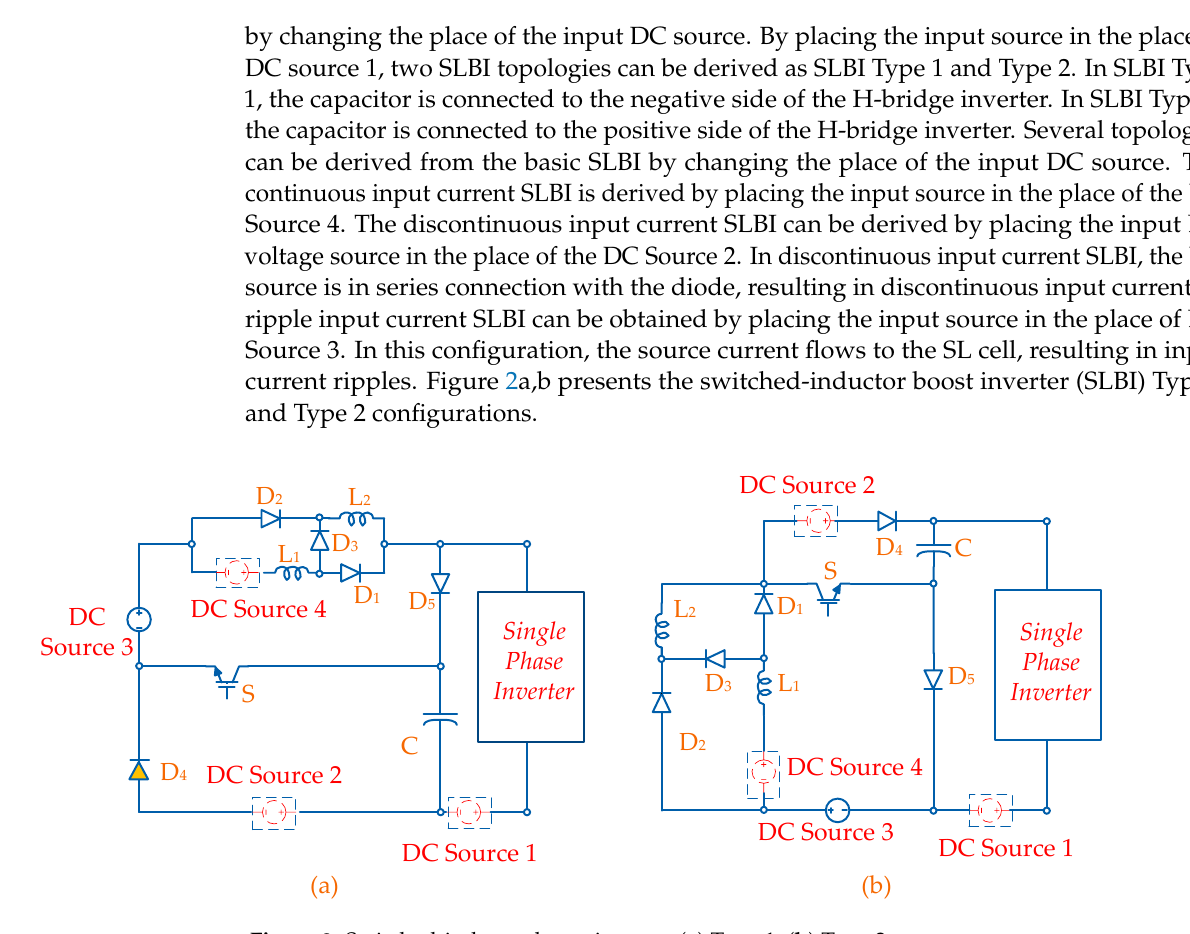
Figure 2. Switched-inductor boost inverter ( a ) Type 1; ( b ) Type 2.